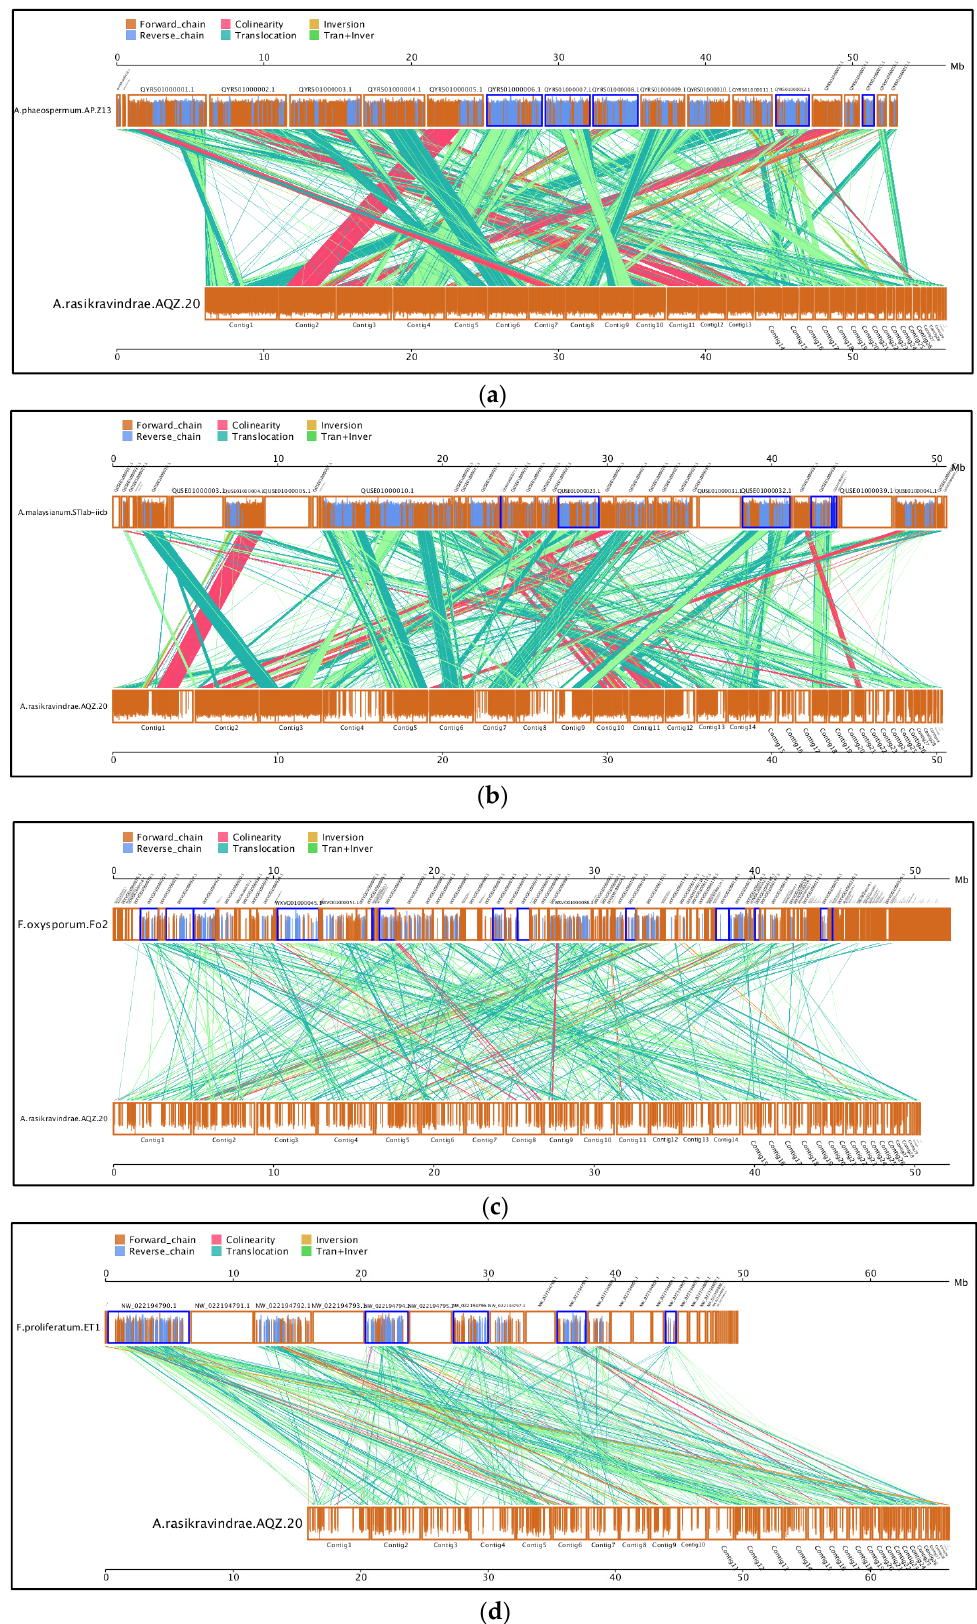
Figure 5. Parallel collinearity comparison analysis between Arthrinium rasikravindrae AQZ-20 and the A. phaeospermum AP-Z13, A. malaysianum STlab-iicb, F. proliferatum ET1, F. oxysporum Fo2, and A. rasikravindrae species. This figure shows the comparative genomic analysis between A. rasikravin- drae and four other closely related fungus from the same genus Ascomycetes. In which two fungus are from the same family while the other two are from different families. ( a ) collinearity between A. rasikravindrae and A. phaeospermum strain AP-Z13, ( b ) collinearity between A. rasikravindrae and A. malaysianum STlab-iib, ( c ) collinearity between A. rasikravindrae and F. proliferatum ET1, and ( d ) col- linearity between A. rasikravindrae and F. oxysporum Fo2 species. While at top left side of these fig- ures ( a – d ) scale has been shown with different colors and corresponding names. The parallel lines with boxes upside and downside represent the contigs number while these are counted by the scale 0–60 MB upside the parallel lines. 3.13.2. The Core and Pan Genomic Analysis The core genes are a set of genes with direct involvement in the disease pathway, while the pan-genes are the entire set of genes within a clade. The number of specific genes in A. rasikravindrae and A. phaeospermum was found to be 6337 and 8372, harmoniously, the core genes number was 2839, and the pan genes number was 427. The specific genes number in A. malaysianum was 8055, the core genes number was 3480, and the pan genes number was 520, respectively. The specific genes number in F. oxysporum Fo2 was 8492, the core genes number was 6809, and the pan genes number was 3396, respectively. The specific genes number in F. proliferatum was 11,158, the core genes number was 6935, and the pan genes number was 3438, respectively (Figure 6a).